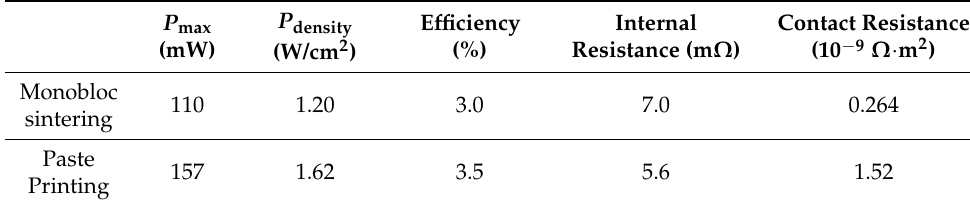
Table 1. Characteristics of single TE chips for power generation with hot and cold temperatures of 873 and 373 K, respectively, and the contact resistivity at the Ni-electrode/Mg 2 Si interface. The TE material was Mg 2 Si doped with Sb and Zn to enhance the n-type TE properties. The sample size was 3 mm × 3 mm × 7.6 mm. P density P max Efficiency Internal Contact Resistance (%) Resistance (m Ω ) (10 − 9 Ω · m 2 (mW) (W/cm 2 )